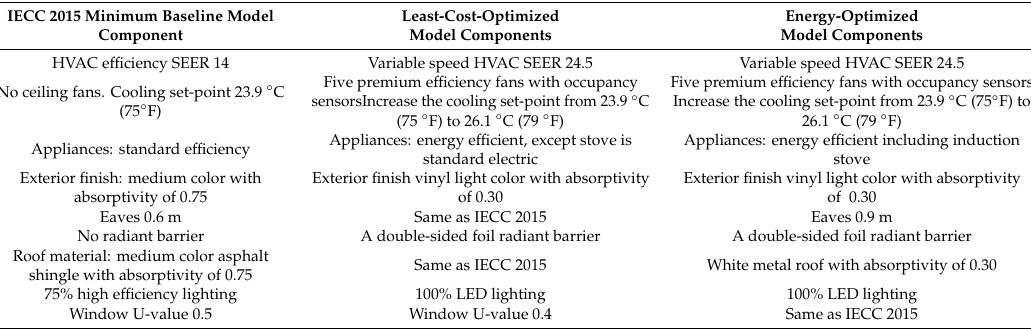
Table 7. Component di ff erences between the IECC 2015 minimum baseline model, the least-cost-optimized model, and the energy-optimized